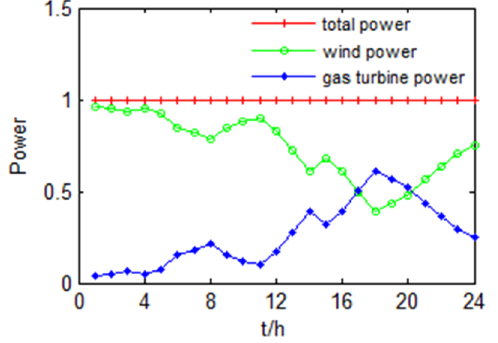
Figure 4. Scheduling discipline of a wind-gas turbine hybrid power